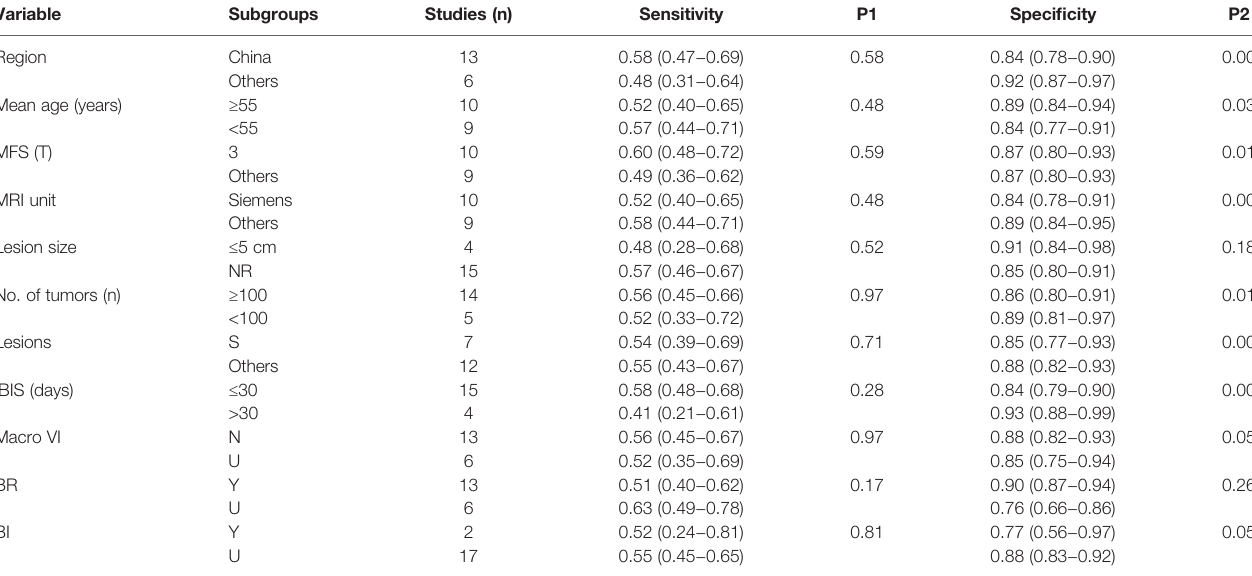
TABLE 4 | Subgroup analyses of peritumoral hypointensity on hepatobiliary phase. Variable